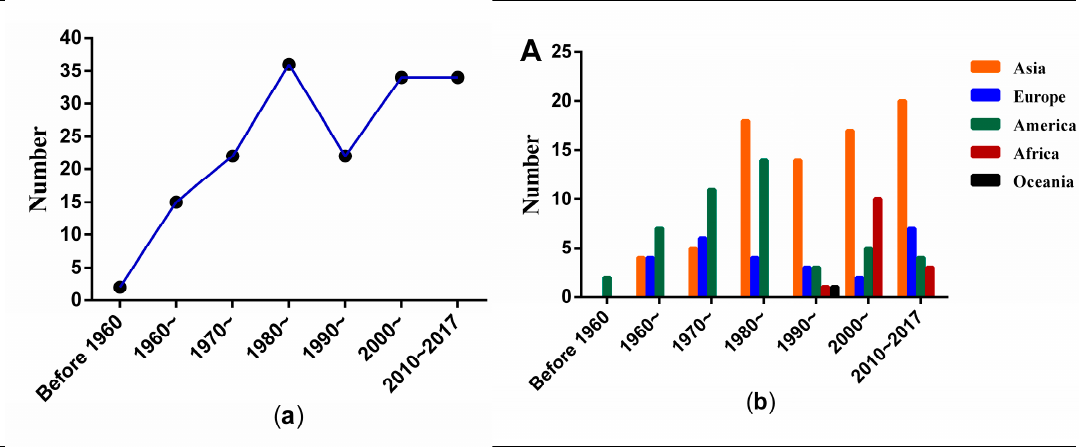
Figure 2. The distribution of 165 included articles: ( a ) by publication year; ( b ) by continents and year.